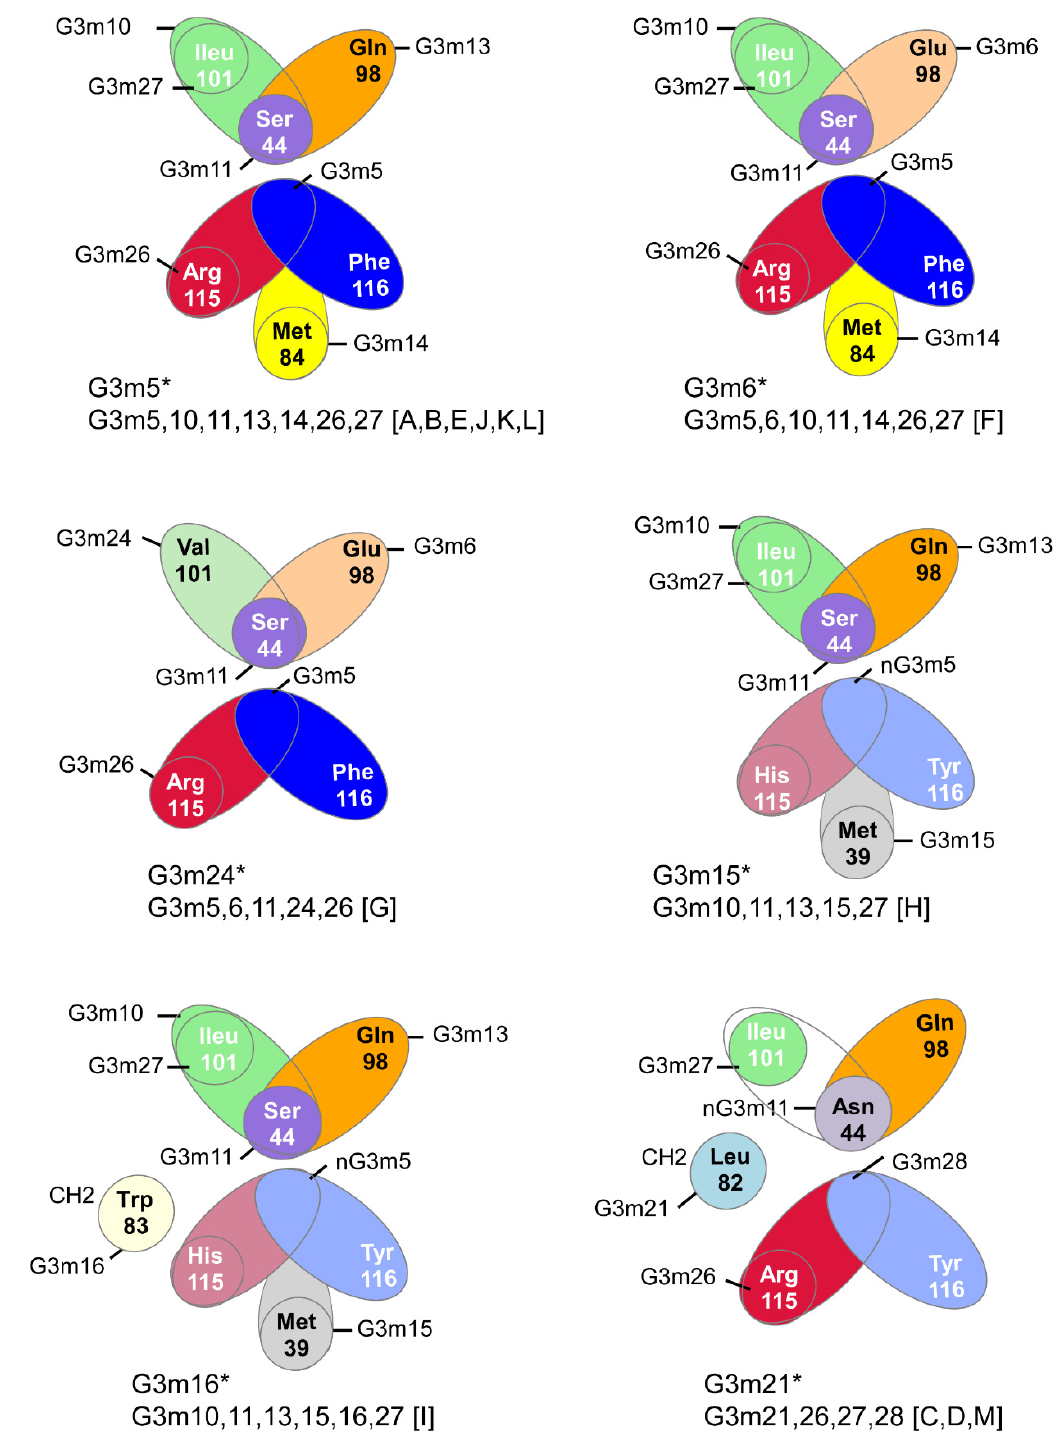
Figure 41. IMGT G3m allele butterfly’ representation [83]. The two mosaics on the CH3 domain are shown for each G3m allele (allotypes are described in [83]). The first mosaic around G3m11 is on the top with G3m27, G3m10/G3m24, G3m13/G3m6. The second mosaic is at the bottom with G3m26, G3m5/nG3m5/G3m28. Amino acids involved in the allotype expression and their position according to the IMGT unique numbering for C domain [42] are indicated. Two allotypes are on the CH2 domain, G3m16 (Trp W83) and G3m21 (Leu L82). Haplotypes to which the G3m alleles belong, are indicated between square brackets. (With permission from M ‐ P. Lefranc and G. Lefranc, LIGM, Founders and Authors of IMGT ® , the international ImMunoGeneTics information system ® , http://www.imgt.org).